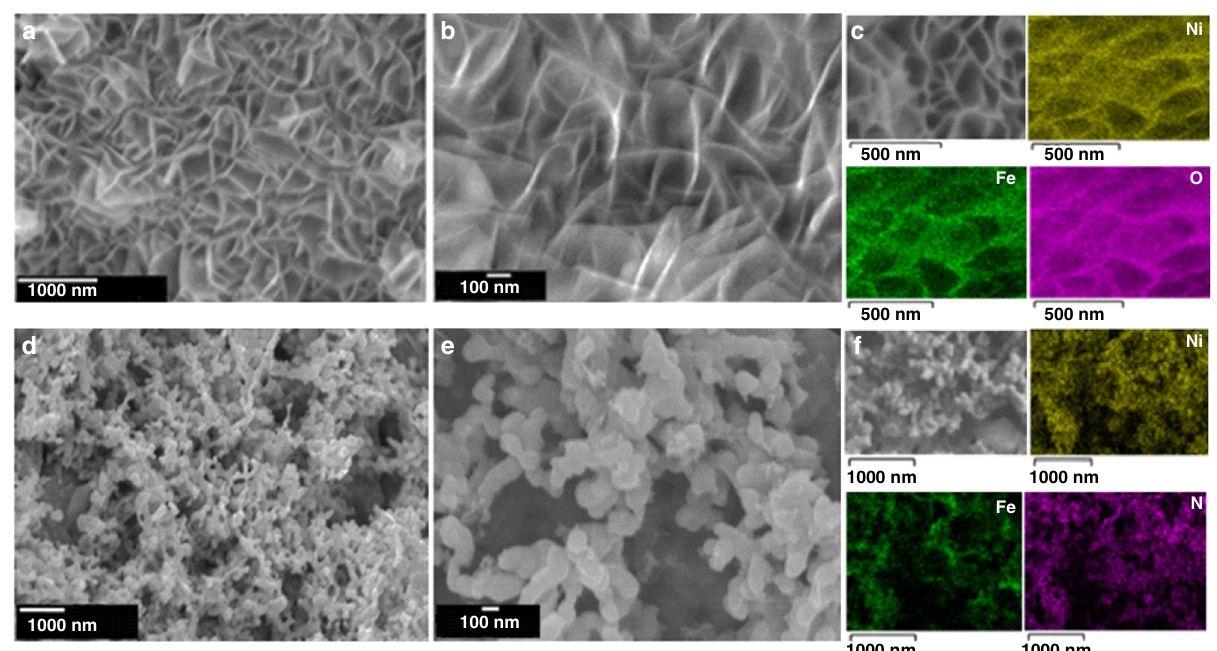
Fig. 2 Morphology and elemental compositions of the electrocatalysts. SEM images of the NiFeO x -NF catalyst in low ( a ) and high ( b ) magni fi cation; c EDS elemental mapping of the NiFeO x -NF catalyst; SEM images of the NiFeN x -NF catalyst in low ( d ) and high ( e ) magni fi cation; and f EDS elemental mapping of the NiFeN x -NF catalyst.